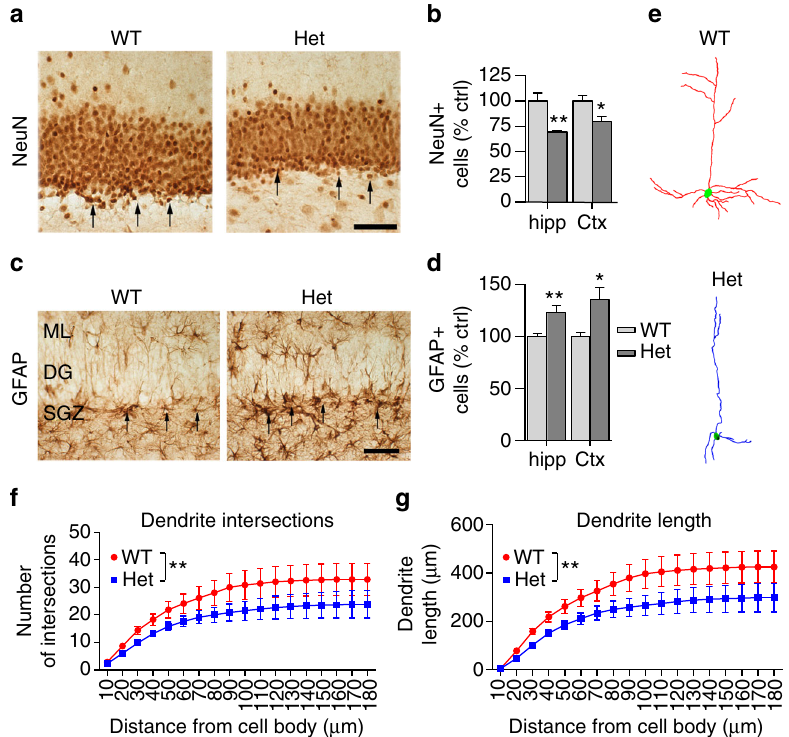
Fig. 3 Mef2c -het mice exhibit abnormal neuronal properties. a Immunohistochemistry showing NeuN+ cells in the dentate gyrus (DG) of WT and Mef2c - het mice. b Quanti fi cation showing decreased NeuN+ cell counts in hippocampus (hipp) and cortex (Ctx) in Mef2c -het mice relative to WT. Hippocampal measurements were obtained on granule cells in the molecular layer of the DG, and the cortical measurement on frontal lobe layers IV and V. c , d Increased number of GFAP+ cells consistent with astrocytosis in Mef2c -het mice. e Neurolucida drawing of representative dendrites visualized by Golgi staining in V1 (primary visual cortex), M2ML (secondary visual cortex mediolateral area), and LPtA (lateral parietal association cortex) of the visual cortex of WT and Mef2c -het mice. f , g Summary graphs of Sholl analysis showing reduction in cumulative number of dendritic intersections ( f ) and dendritic lengths ( g ) in Mef2c -het neurons. Scale bar: 50 µ m. Data are mean ± s.e.m.; n = 4 per group. * P < 0.05, ** P < 0.01 by Student ’ s t test in a – d and ANOVA